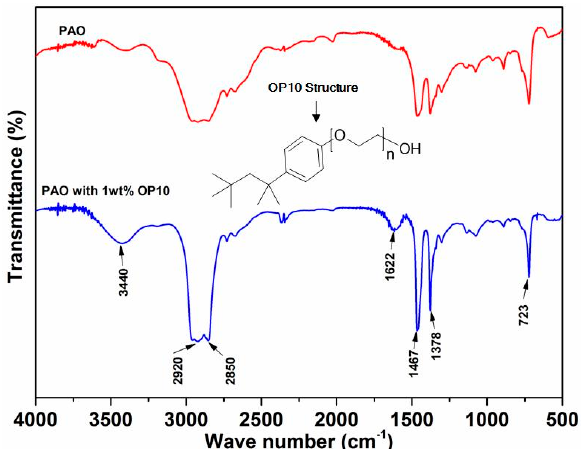
Figure 4. The FTIR spectra of base oil with and without added surfactant.